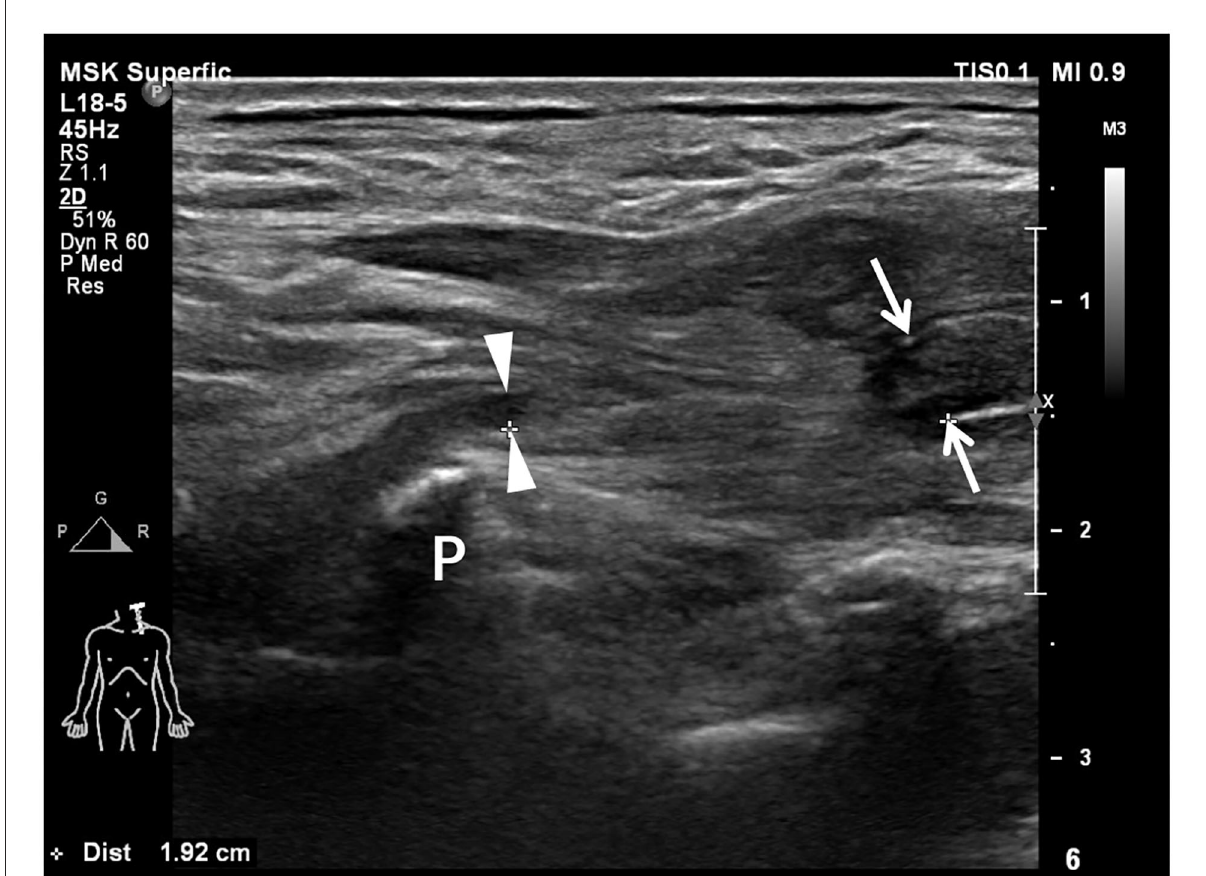
FIGURE2 Longitudinal sonogram shows a completely transected brachial plexus root with a 1.92-cm-long neural gap between the proximal end (arrowheads) and the distal end (arrows). The proximal root end is adjacent to the transverse process (P). The caliber of the distal root end is enlarged in comparison with the proximal root